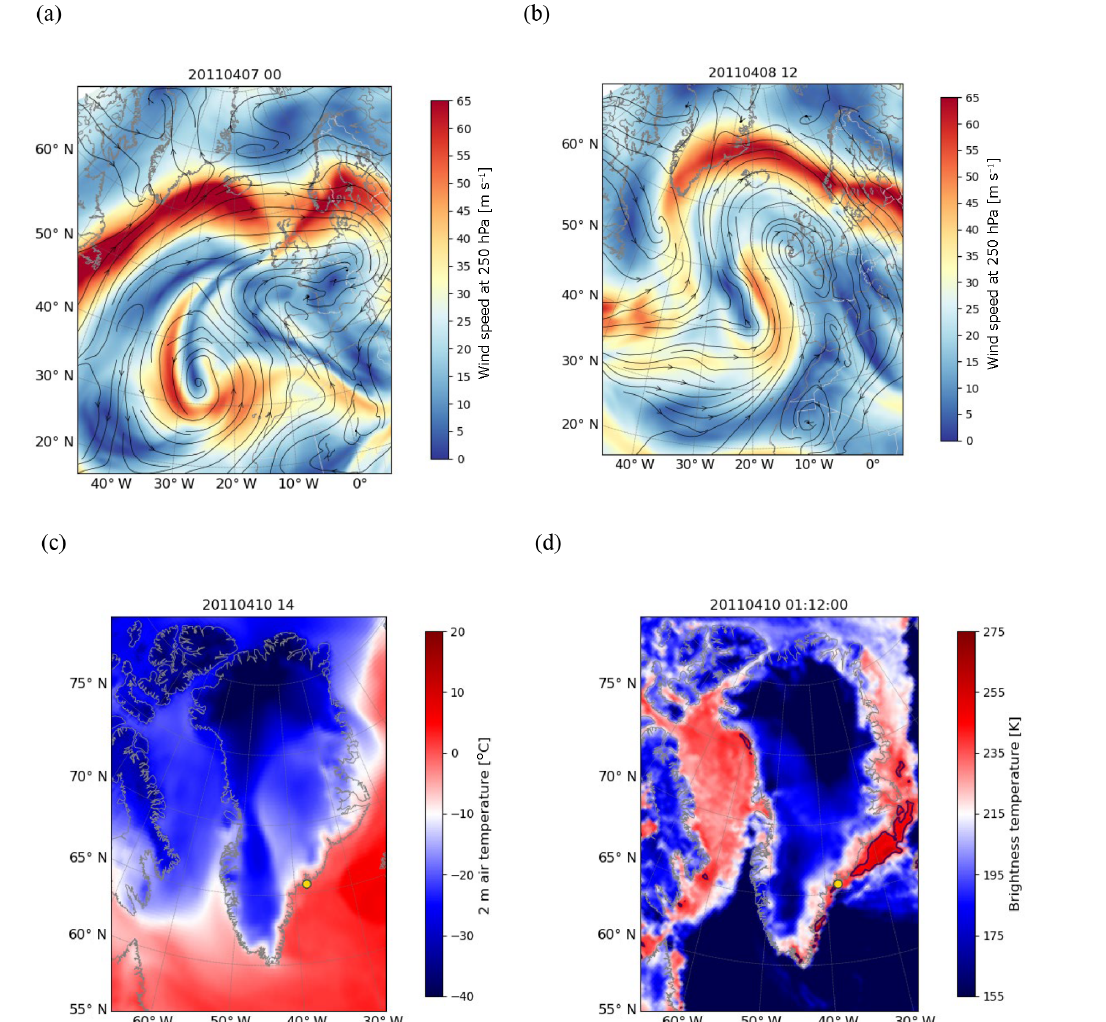
Figure 3. ECMWF ERA5 reanalyses of Wind Speed at 250hPa (colors) and wind direction at 700hPa (streamlines) on (a) 7 April at 00:00UTC and (b) 8 April 2011 at 12:00UTC. 2m air temperature from ERA5 reanalysis on 10 April 2011 at 14:00UTC (c) and AMSR-E brightness temperature at 36GHz horizontal polarization for the night path (around 01:00UTC) on 10 April 2011 (d) . The yellow circle represents the position of the MIT PROMICE station and the black contour represents the threshold of 248K set for ice melt detection in the AMSR-E data over